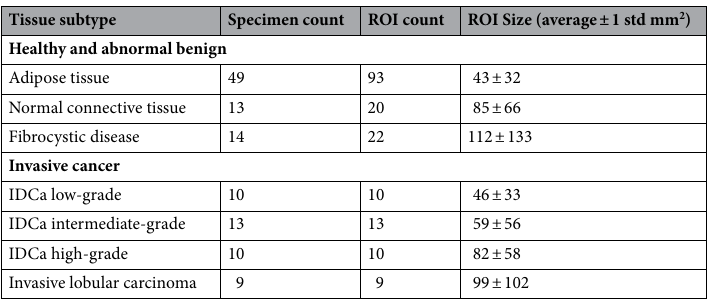
Table 1. Breast tumor specimen and ROI totals by tissue subtype in this study. IDCa invasive ductal carcinoma.